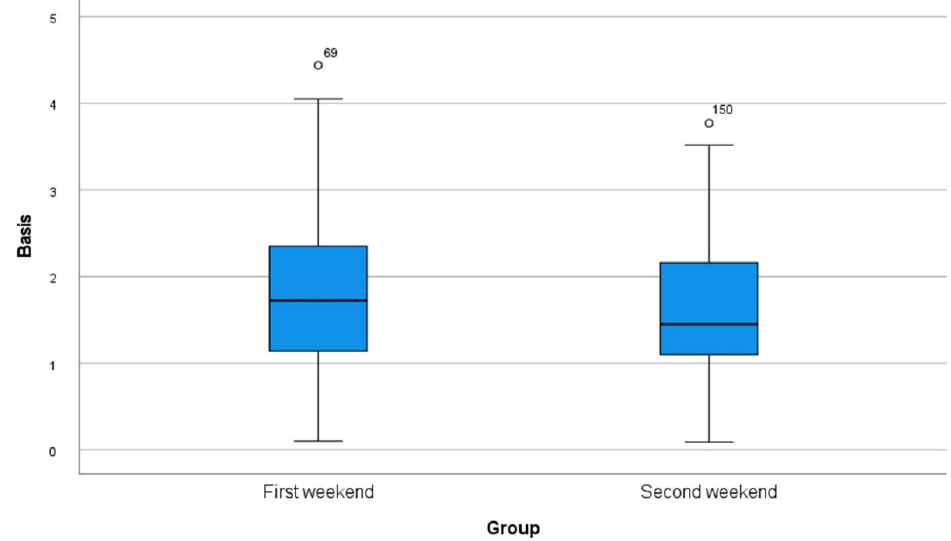
Figure 5. Box plot of all measurements of deviations in the exact positions in vestibular/oral and mesial/distal direction (basis) regarding the master typodont.